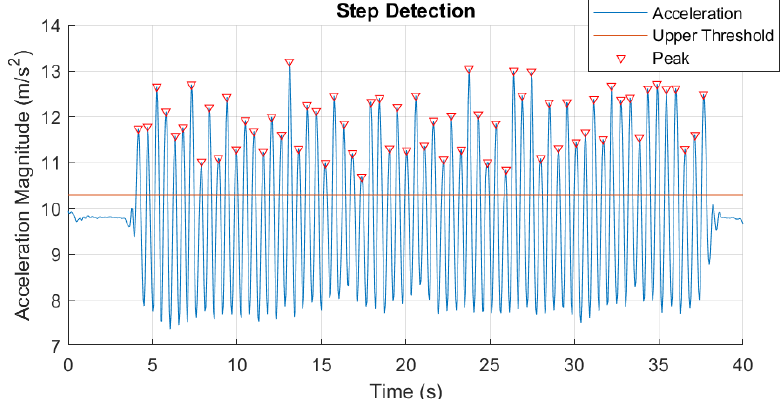
Figure 1. Step detection